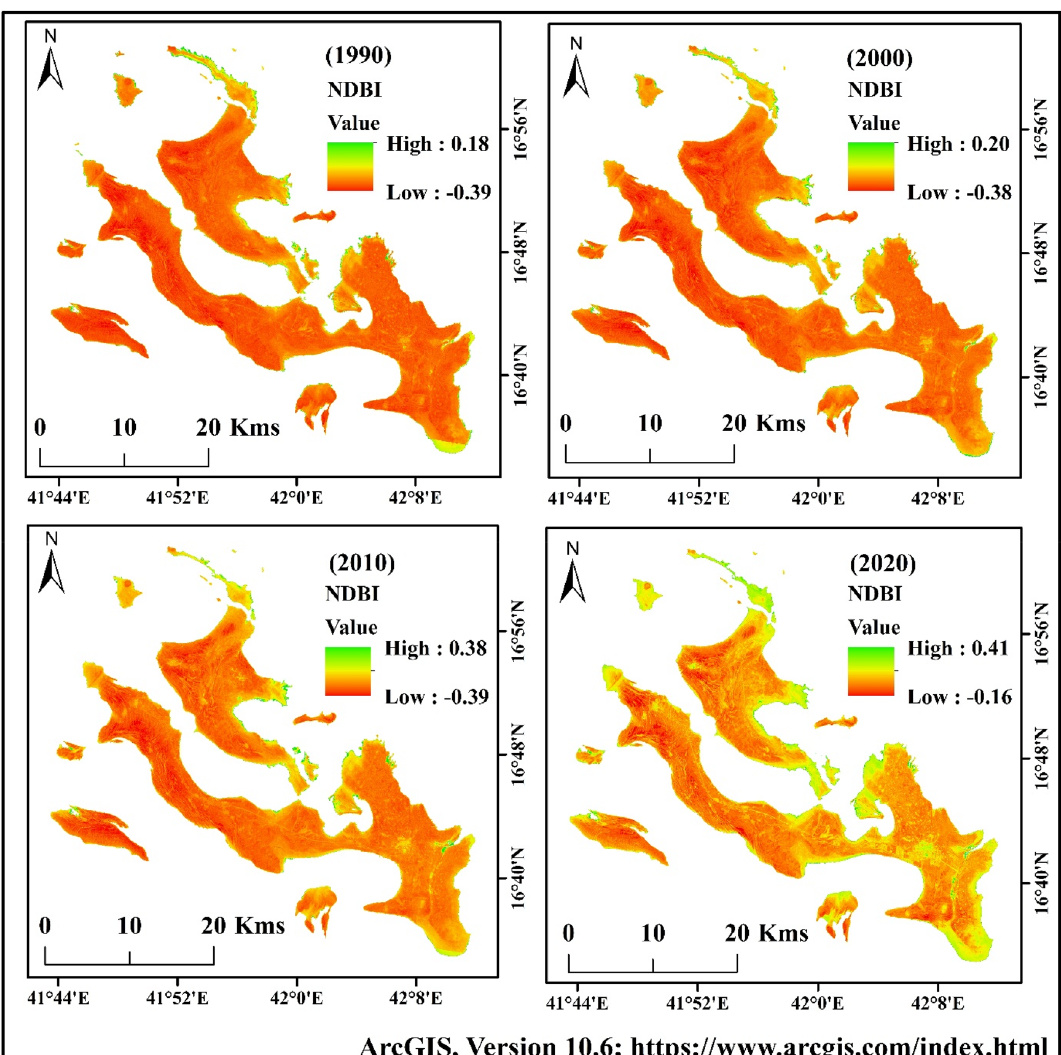
Figure 6. Normalized Different Built-up Index (NDBI) maps of Farasan Island for 1990, 2000, 2010, and 2020 31,64 . The satellite data was downloaded from USGS earth explorer (https:// earth explo rer. usgs. gov/). The map was generated using ArcGIS software, version 10.6 (https:// suppo rt. esri. com/ zh- cn/ produ cts/ deskt op/ arcgis- deskt op/ arcmap/